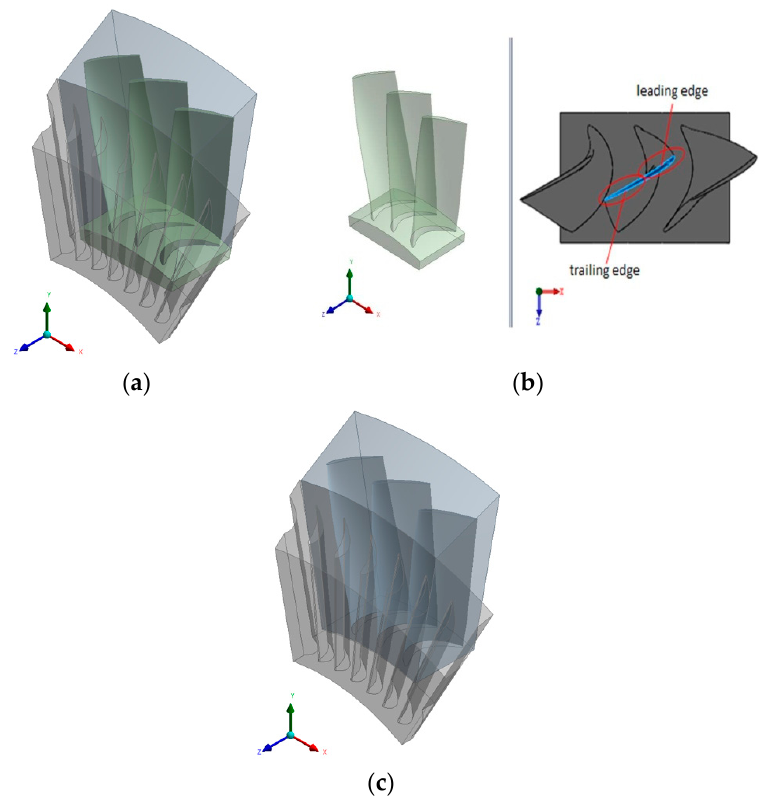
Figure 3. Analysis models of the blades and the flow field. ( a ) Analysis model; ( b ) blade model; ( c ) flow field model.